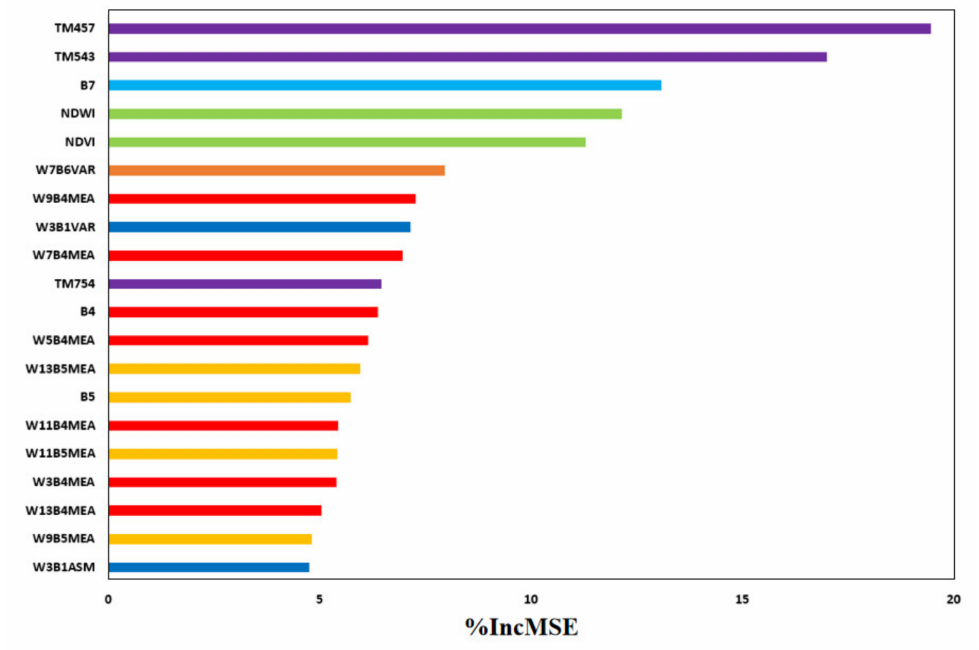
Figure 4. Importance of the top 20 variables (in terms of percentage increase of mean square error). WiBjxxx indicates GLCM texture xxx based on band j with window size i × i . (e.g., W7B6VAR indicates the sixth band’s variance with a window size of 7 ×